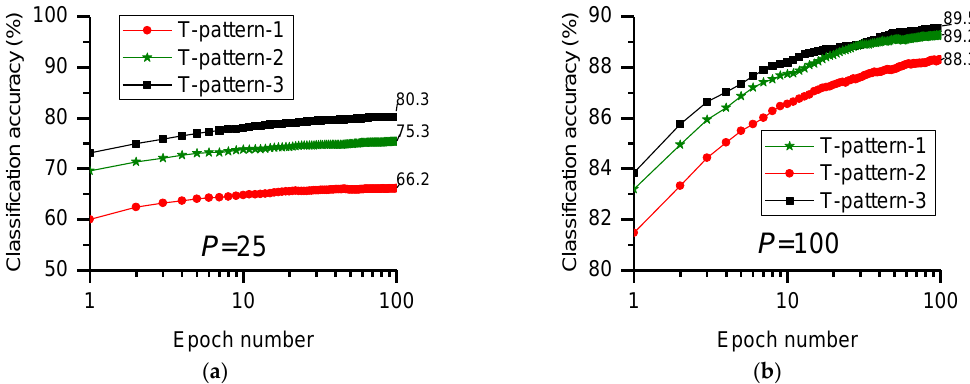
Figure 4. The dependence of the classification accuracy on the number of epochs, for di ff erent T-patterns. The numbers of reservoir neurons: P = 25 ( a ), P = 100 ( b ) and r = 1.885.